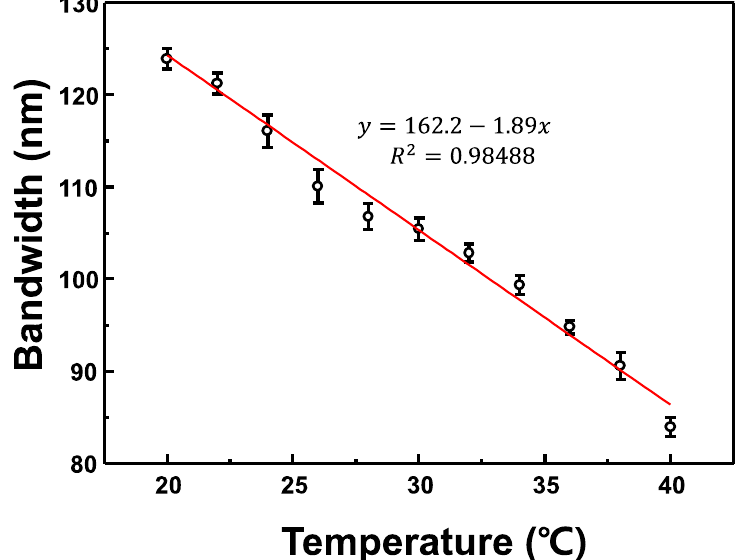
Figure 7. Graphs of the reflection spectrum bandwidth of the CLC cell with changes in temperature.